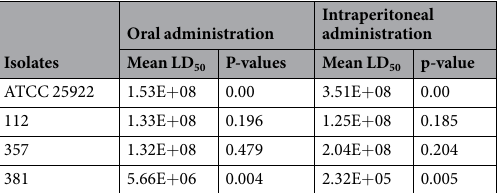
Table 3. Determination of LD50 of the three multidrug resistant E. coli isolates in two-day old